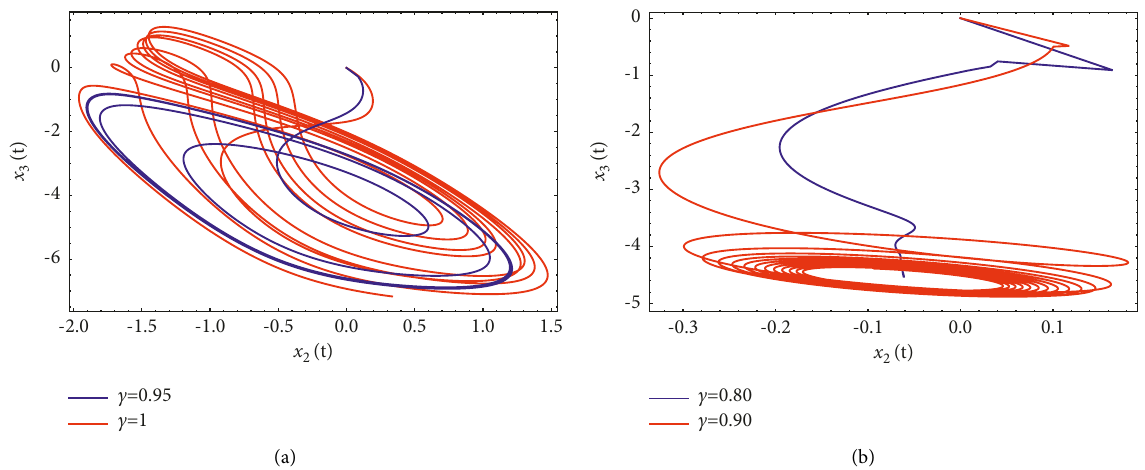
Figure 7: Dynamics of coexisting multiple attractors’ for gradient β orders. (a) State variables x 2 versus x 3 ; (b) state variables x 2 versus x 3 .